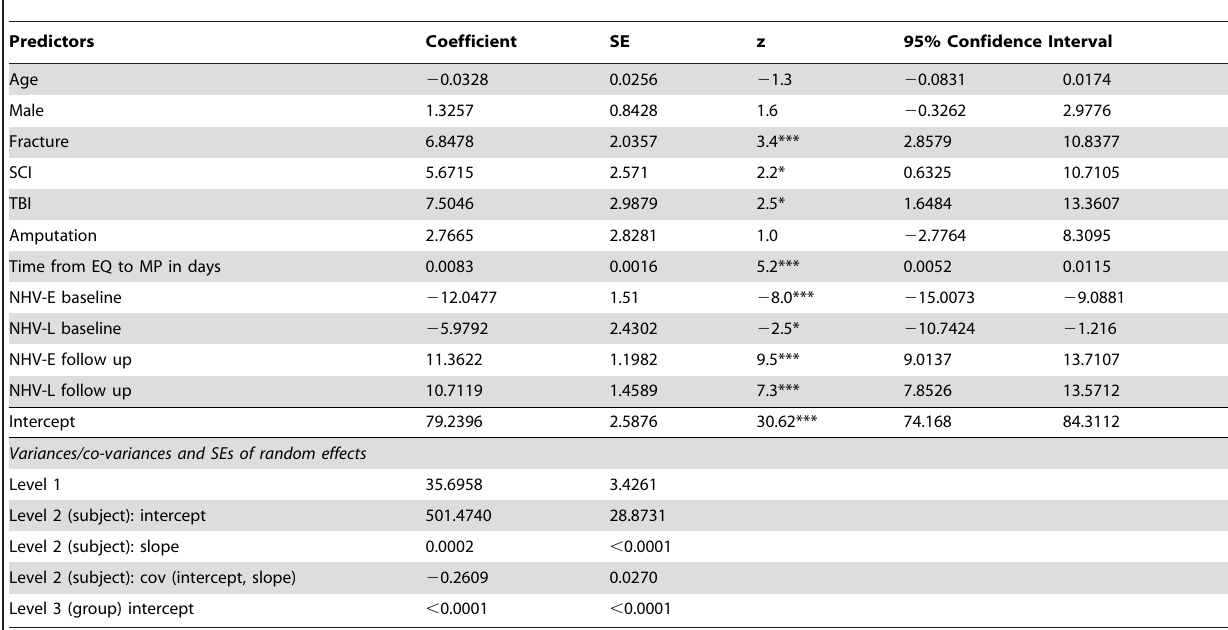
Table 2. Parameter estimates for Barthel Index (BI) based on the three-level Tobit model.